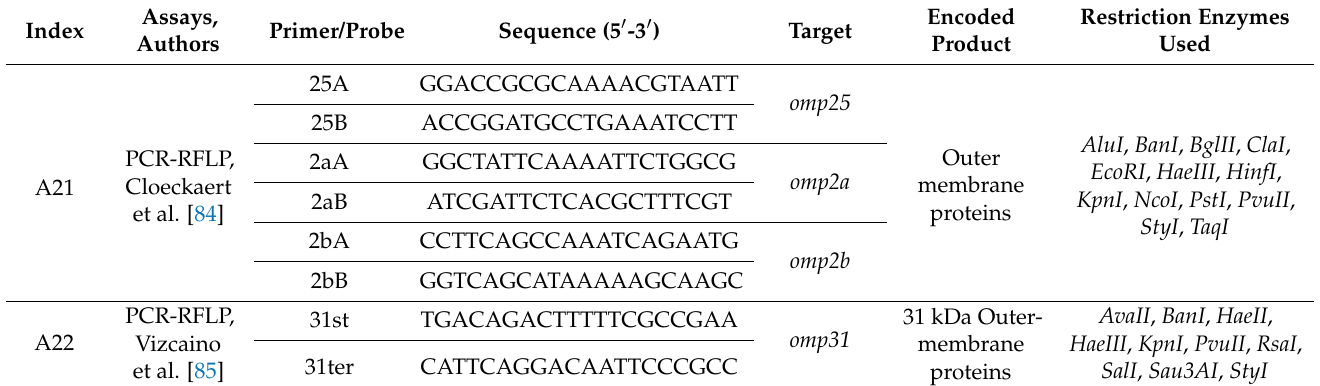
Table 3. Primers from the reviewed PCR-RFLP